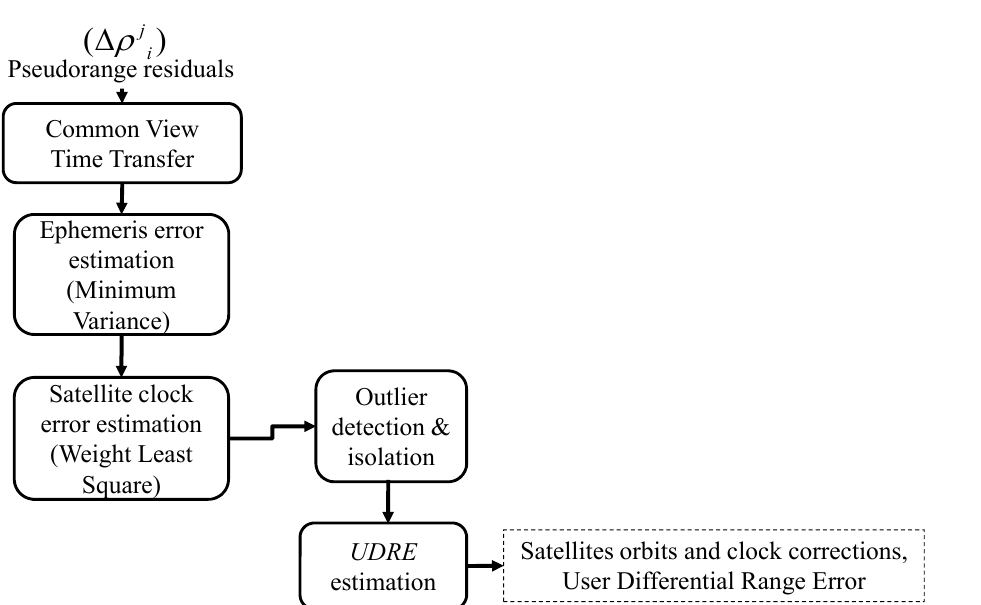
Figure 7. Ephemeris and clock errors estimation flow